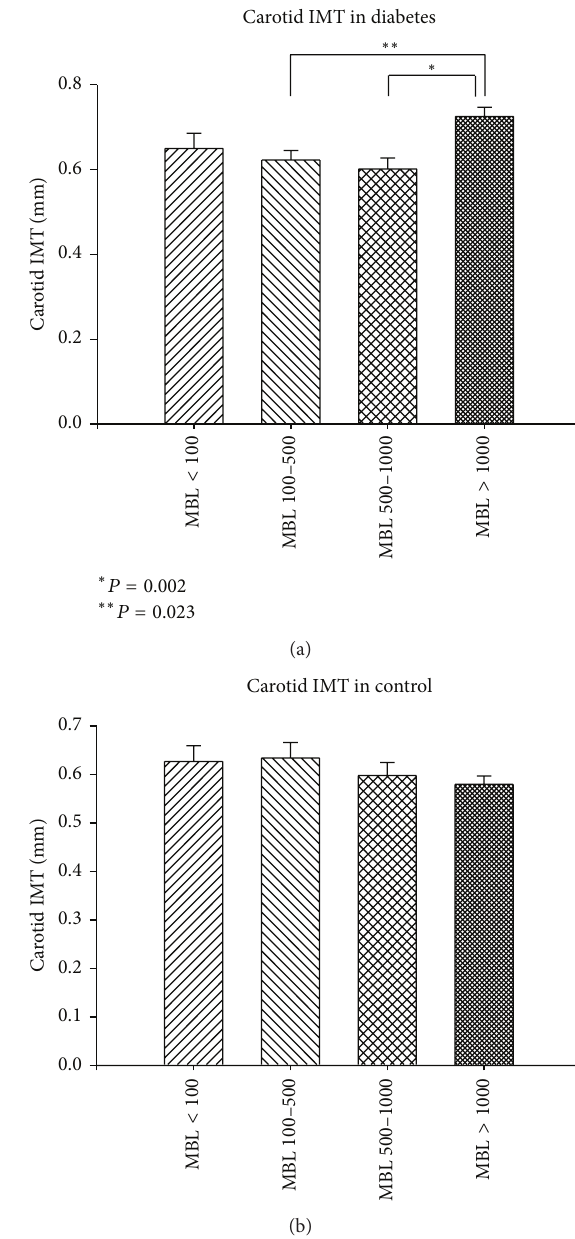
Figure 4: Carotid intima-media thickness (IMT) (mm) in various MBL subgroups in diabetics and controls. Amongst the controls, there was no significant difference in IMT in the four MBL sub- groups. In diabetics, lowest IMT was seen in subgroup with normal MBL level (500–1000 ng/mL) while IMT continuously increased with both high MBL and absolute MBL